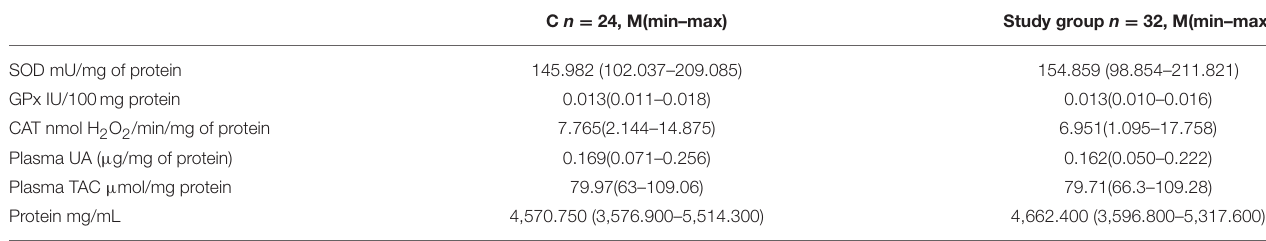
TABLE 1 | Enzymatic, non-enzymatic antioxidants and protein concentration in blood cells or plasma of the control and examined patients. C n = 24, M(min–max)